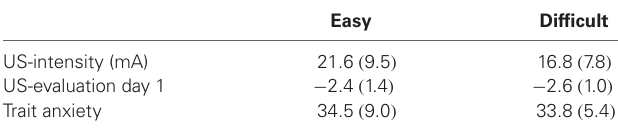
Table 1 | Mean values (SD) of the US-intensity, US-evaluation, and trait anxiety (STAI-T) for the Easy ( n = 16) and Difficult conditions ( n = 18)